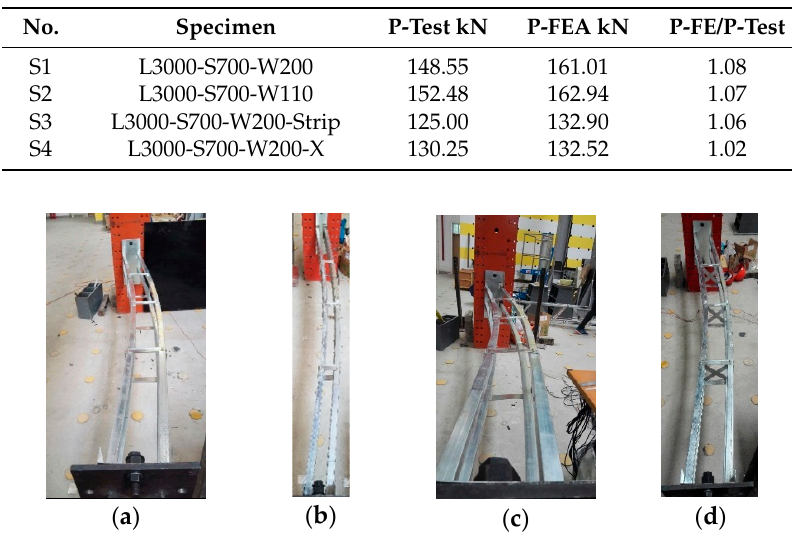
Table 3. Results of test and finite element analysis.